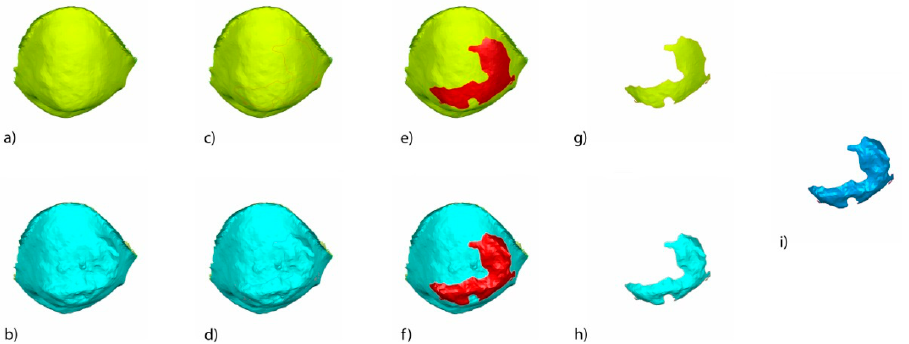
Figure 5. Palatal perspective of tooth 1.5 segmented on STL1 ( a ) and STL3. ( b ) Boundary creation on STL1 ( c ) and STL3. ( d ) Boundary selection of the cement remaining on STL1 ( e ) and STL3. ( f ) Mesh of the cement remaining on STL1 ( g ) and STL3 ( h ), and the combined meshes with the remaining cement after bracket removal from STL1 and STL3, obtaining a closed polygon ( i